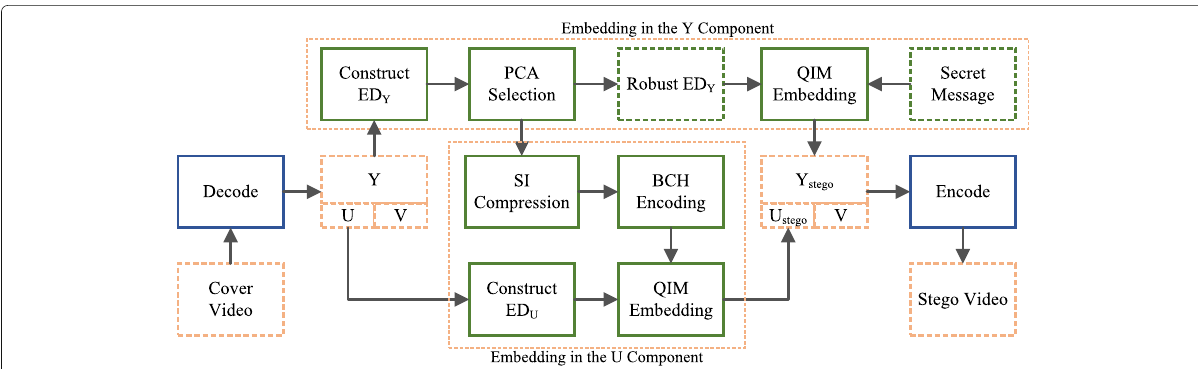
Fig. 3 The steganographic framework based on PCA selection. ED Y and ED U are the embedding domains constructed from the Y and U components, respectively. SI is the side information that labels PCA-selected regions. Y, U, and V represent the luminance and chrominance components. Y stego and U stego are the steganographic version of Y and U,